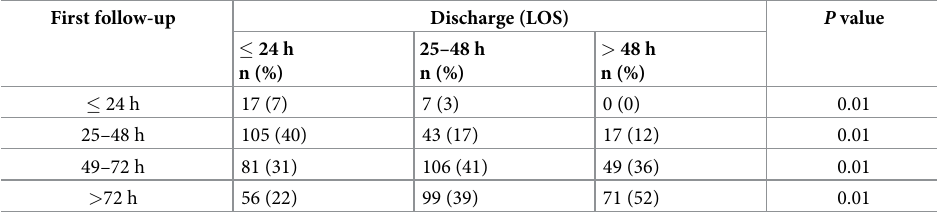
Data are numbers and (percentages). (cid:3) The P value is the result of the Pearson’s chi-square tests between the timing of discharge and the timing of the first follow-up